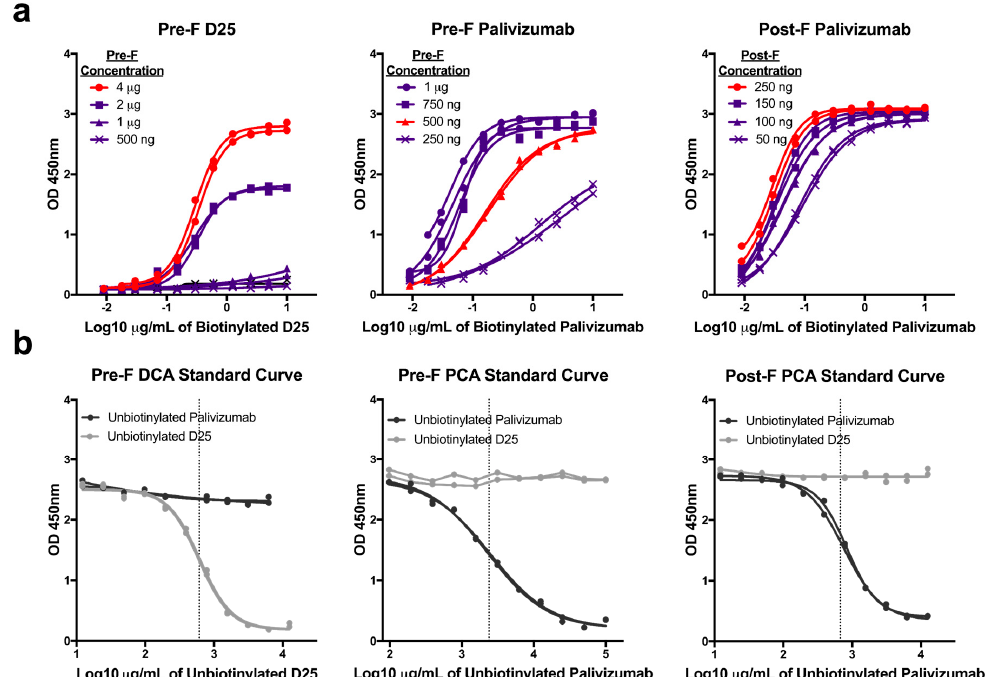
Figure 1. Development of monoclonal antibody (mAb) competition assays. ( a ) Serial dilutions of biotinylated D25 or palivizumab detection antibodies were tested for binding to pre-fusion (pre-F) or post-fusion (post-F) coated overnight on plates at the indicated concentrations. The samples highlighted in red indicate the coating concentration that was selected for each assay. Sub-saturating concentrations of detection antibodies were determined, and final assay conditions selected for each assay were: pre-F DCA: 4 µ g coating, 2 µ g/mL D25, pre-F PCA: 500 ng coating, 2 µ g/mL palivizumab, post-F PCA: 250 ng coating, 0.1 µ g/mL palivizumab. Lines with identical symbols indicate technical replicates. ( b ) Serial dilutions of unbiotinylated D25 and palivizumab were used in each assay to generate a full standard curve and determine the IC 50 of antibody identical to the detection reagent (dotted line). The concentrations of D25-competing antibody (DCA) and palivizumab-competing antibody (PCA) within experimental samples were then interpolated from the absorbance value at which experimental samples achieved 50% inhibition. Lines with identical symbols are technical